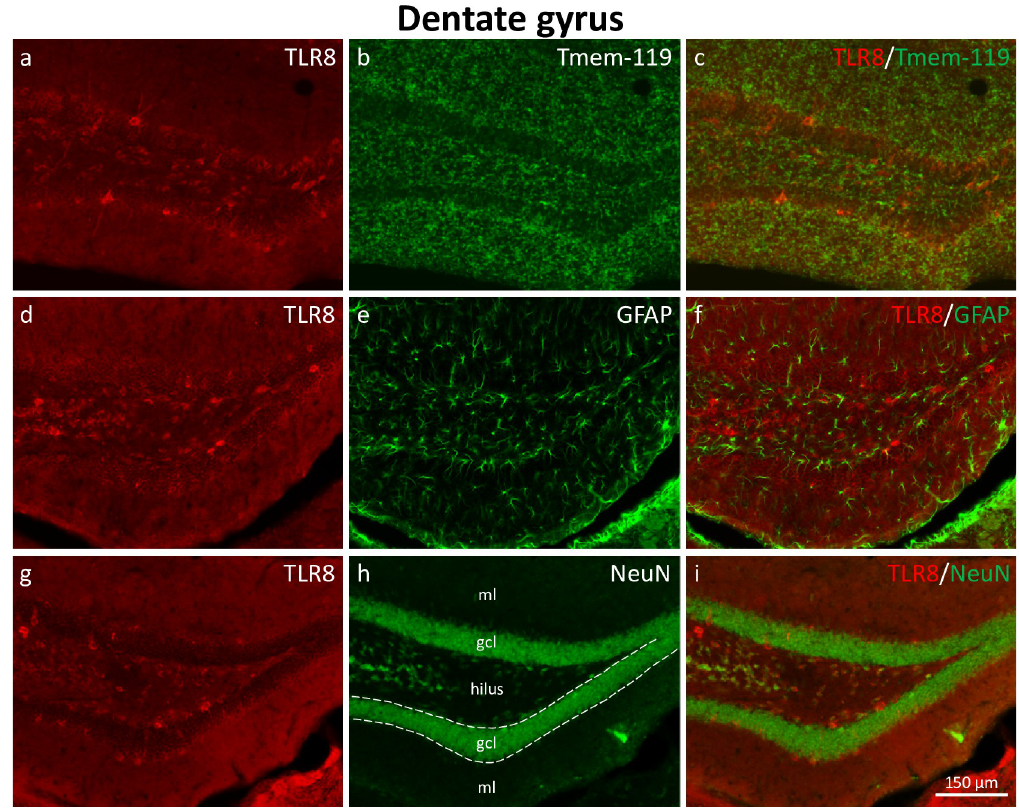
Fig 1. Expression of TLR8 in the dentate gyrus. Double immunofluorescence of TLR8 (red fluorescence; a, d, g) with the microglia marker transmembrane protein 119 (Tmem-119; b, c), the astrocyte marker glial fibrillary acidic protein (GFAP; e, f), and neuron-specific nuclear protein (NeuN; h, i), a marker for adult neurons. TLR8-immunoreactive cells were detected in the hilus of the dentate gyrus, in the supragranular layer, in the granule cell layer, and at the border between the granule cell layer and the inner molecular layer of the dentate gyrus (a, d, g). Cell bodies of granule cells showed only faint labeling. Double immunofluorescence revealed expression of TLR8 in neurons (NeuN, i), but not in glial cells (Tmem-119, c; GFAP, i). Abbreviations: gcl, granule cell layer; ml, molecular